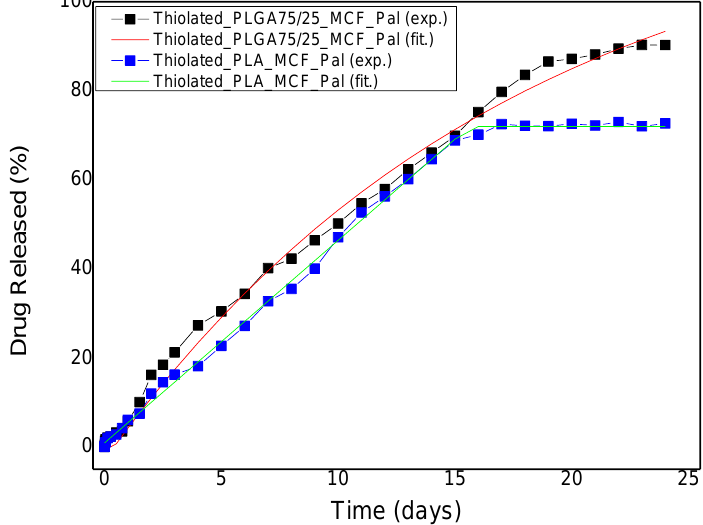
Figure 13. Paliperidone release profile for thiolated PLGA/MCF and PLA/MCF microspheres. The experimental data are shown as symbols and the fitting data as a continuous line.